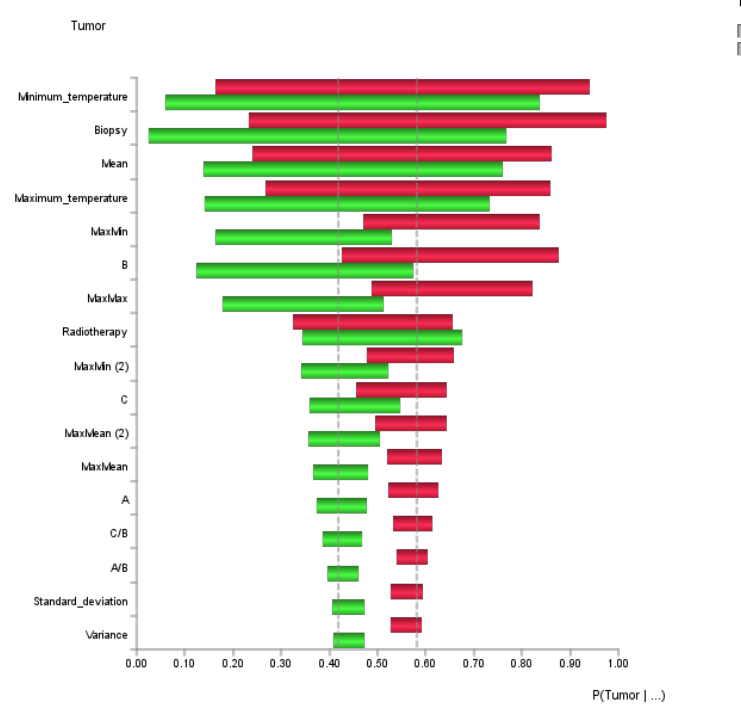
Figure 10. Total effects for the target node tumor.